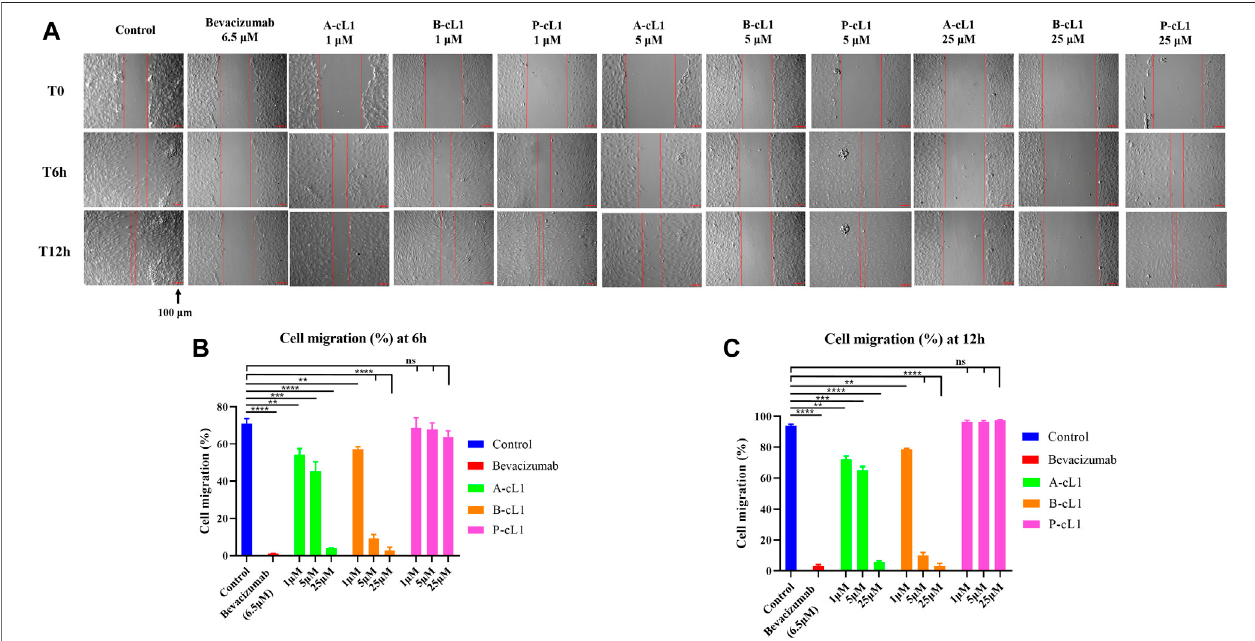
FIGURE 4 | A-cL1, B-cL1, and P-cL1 inhibit VEGF-A (0.2 μ g/ml) stimulated HUVECs migration. (A) Representative images of scratch wound-healing assay. After creation of scratches, HUVECs were cultured in 2% serum medium containing 0.2 μ g/ml VEGF-A, treated with serum-free medium (control group, blue), or with 6.5 µM bevacizumab (positive control, red), or with 1 μ M, 5 and 25 μ M of A-cL1, B-cL1 or P-cL1. Images were taken before the treatment (T0h), after 6 h treatment (T6h) and 12 htreatment(T12h).Scalebar,100 μ m. (B) Quantitativeanalysisofthecellmigration(%)bymeasuringwoundclosureareaafter6 htreatmentusingImageJ. (C) Quantitative analysis of the cell migration (%) by measuring wound closure area after 12 h treatment using ImageJ. The relative cell migration (%) were analyzed with GraphPad Prism 8 (mean ± SEM of three independent experiments), compared to the control group in one-way ANOVA statistical analysis. * p < 0.05, ** p < 0.01, *** p < 0.001, **** p < 0.0001, “ ns ” meaning non-signi fi cant.